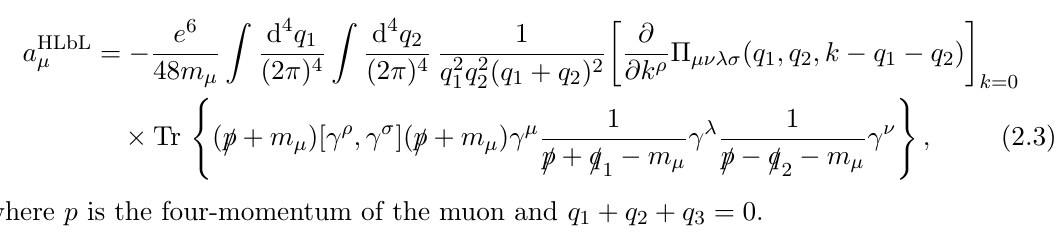
Figure 2. The pion-pole contribution to HLbL scattering of the muon ( g projection technique